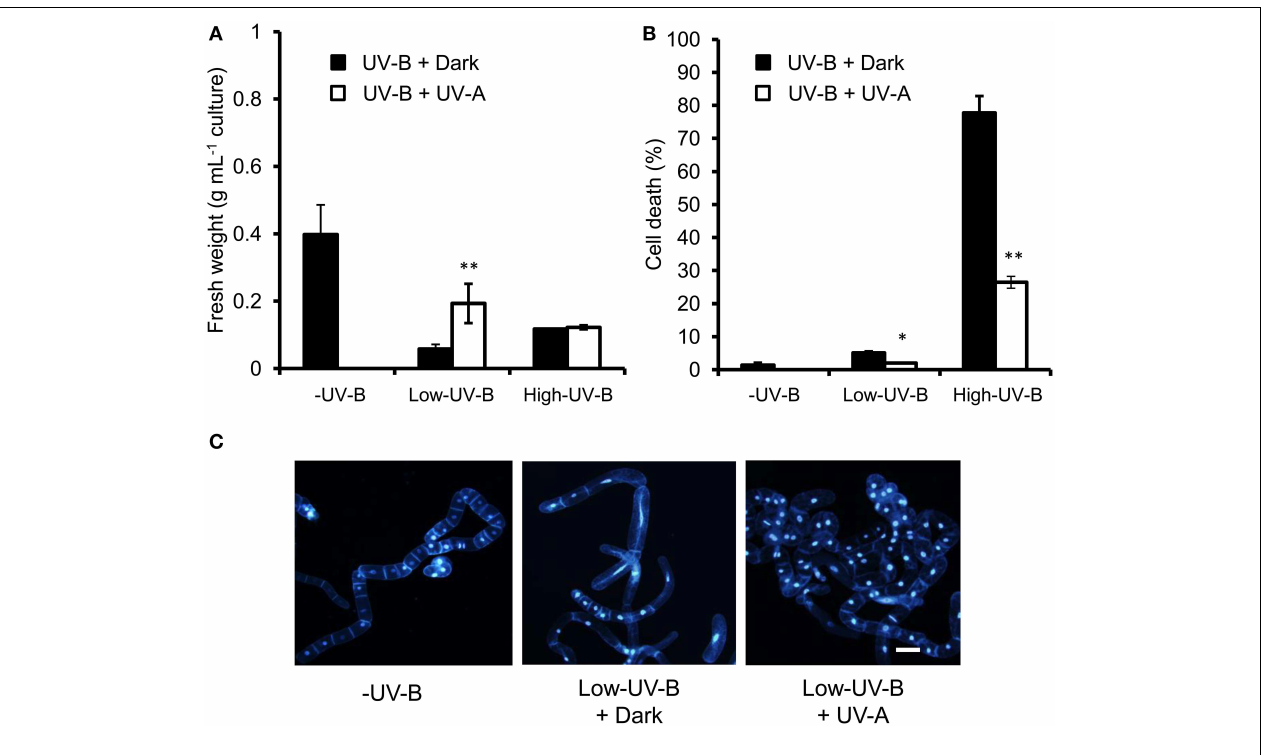
FIGURE 3 | Effects of UV-A radiation on UV-B-induced changes in cell proliferation and cell death. BY-2 cells were irradiated with UV-B (0, 740, or 2960 J m − 2 ), followed by 30-min incubation in the dark (UV-B + Dark) or 30min UV-A irradiation (UVB + UVA). (A) Fresh